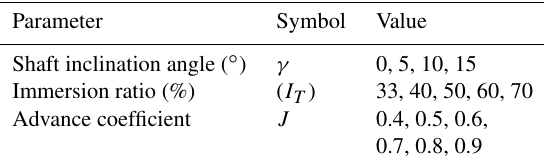
Figure 8. Propeller model ( D =